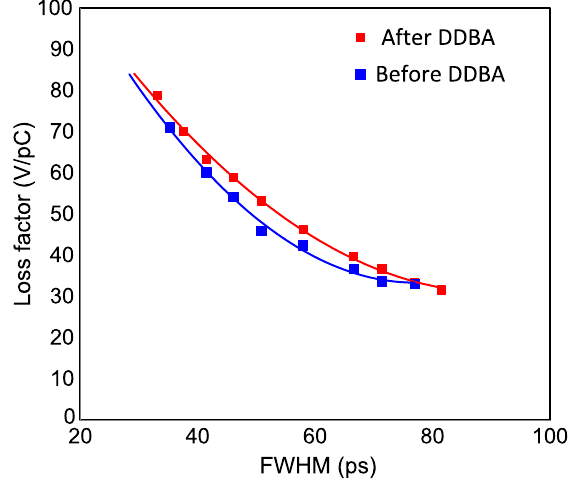
FIG. 10. Loss factor as a function of FWHM bunch length, before and after the installation of the DDBA cell.